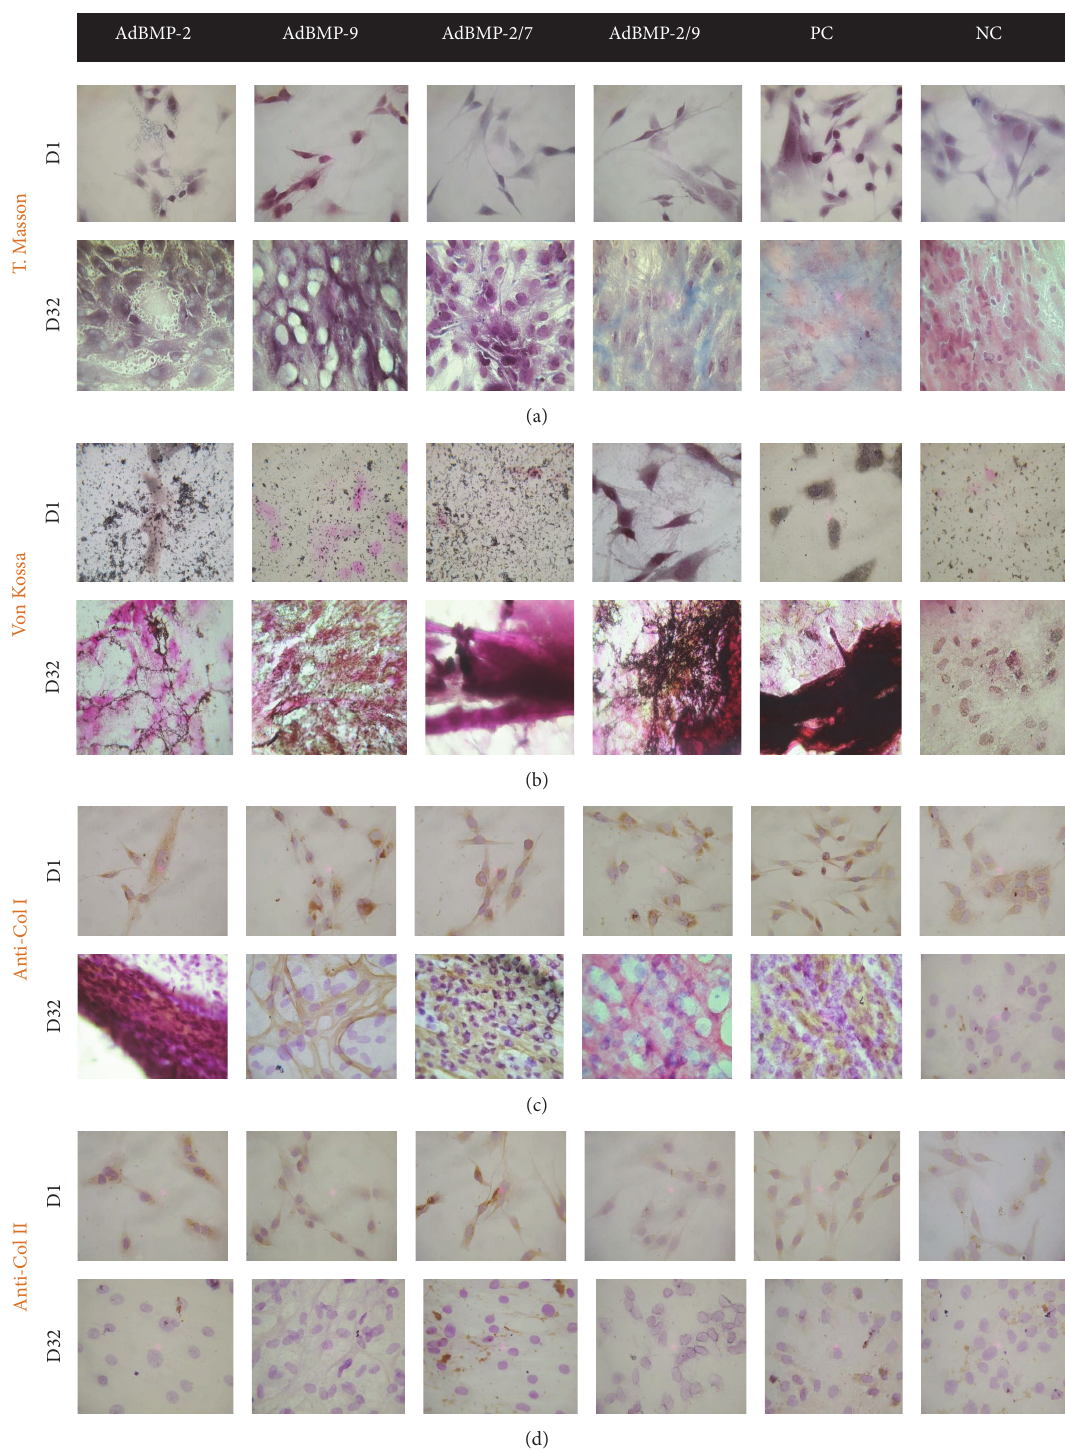
Figure 2: Histological staining at days 1 and 32 of culture. Masson’s trichrome for the identification of collagen and amorphous material; (b) von Kossa for the identification of calcifications; (c) IHC for collagen I; (d) IHC for collagen II. PC: positive control; NC: negative control. Micrographs with 10x